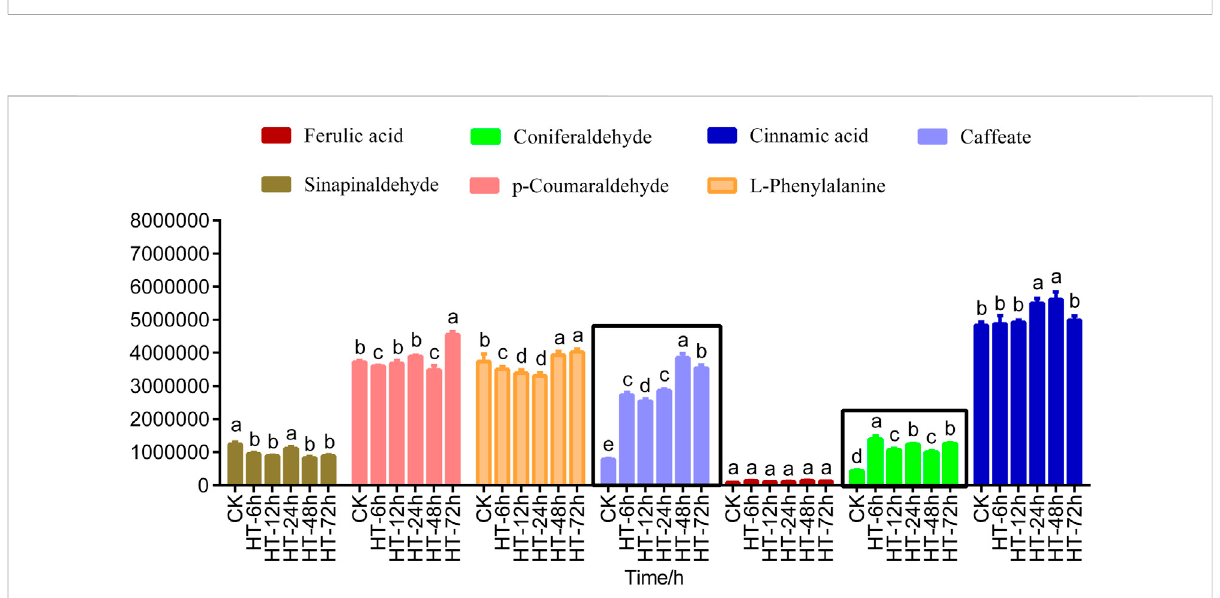
FIGURE 2 Analysis of intermediates in lignin pathway. Histogram of lignin level of 0 (CK), 6, 12, 24, 48, 72 h after treated with heat stimulus. The data showed as the mean ± SE was repeated three times. HT means high temperature. The same letter of P 0.05 level represents the no difference while different P 0.05 level showed the